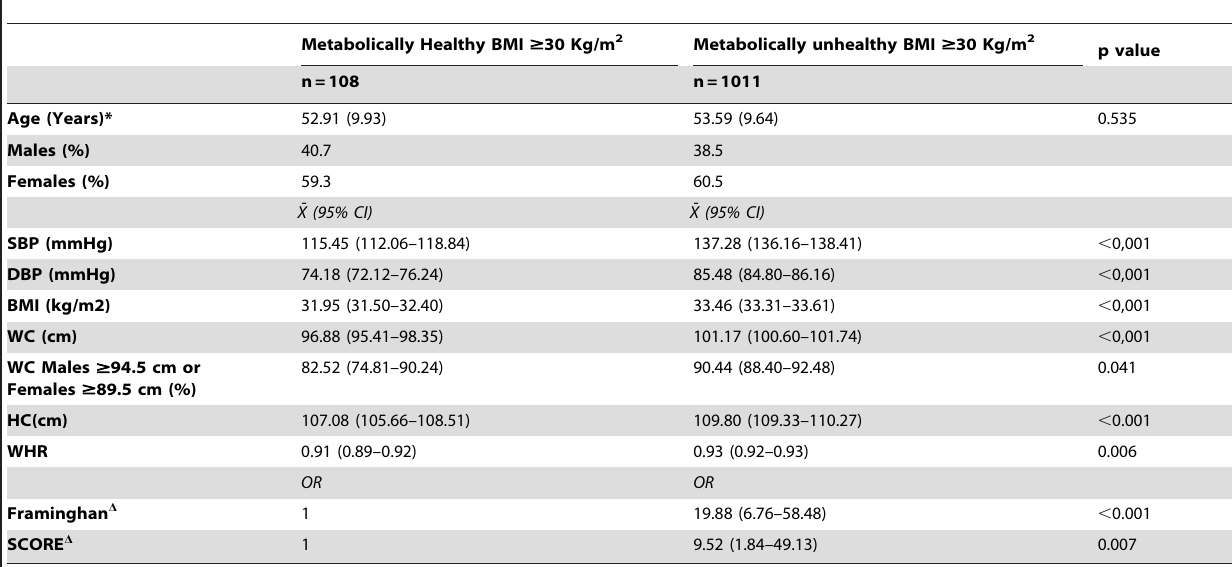
Table 2. Basic characteristics and anthropometric parameters in individuals with BMI $ 30 Kg/m 2 by Wildman criteria, means adjustment by age and sex.